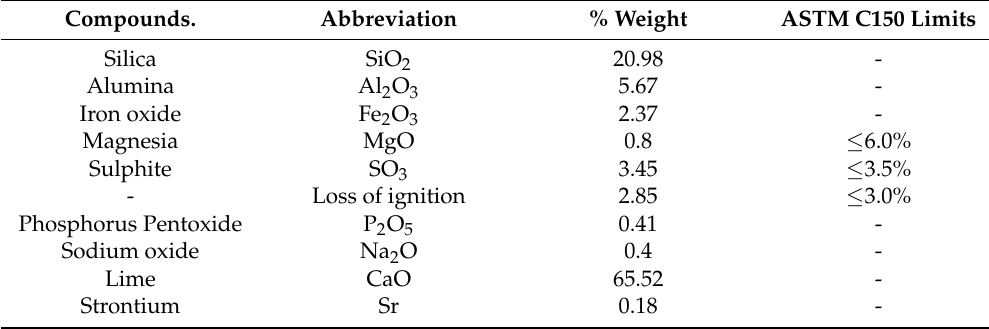
Table 3. Chemical composition of cement.